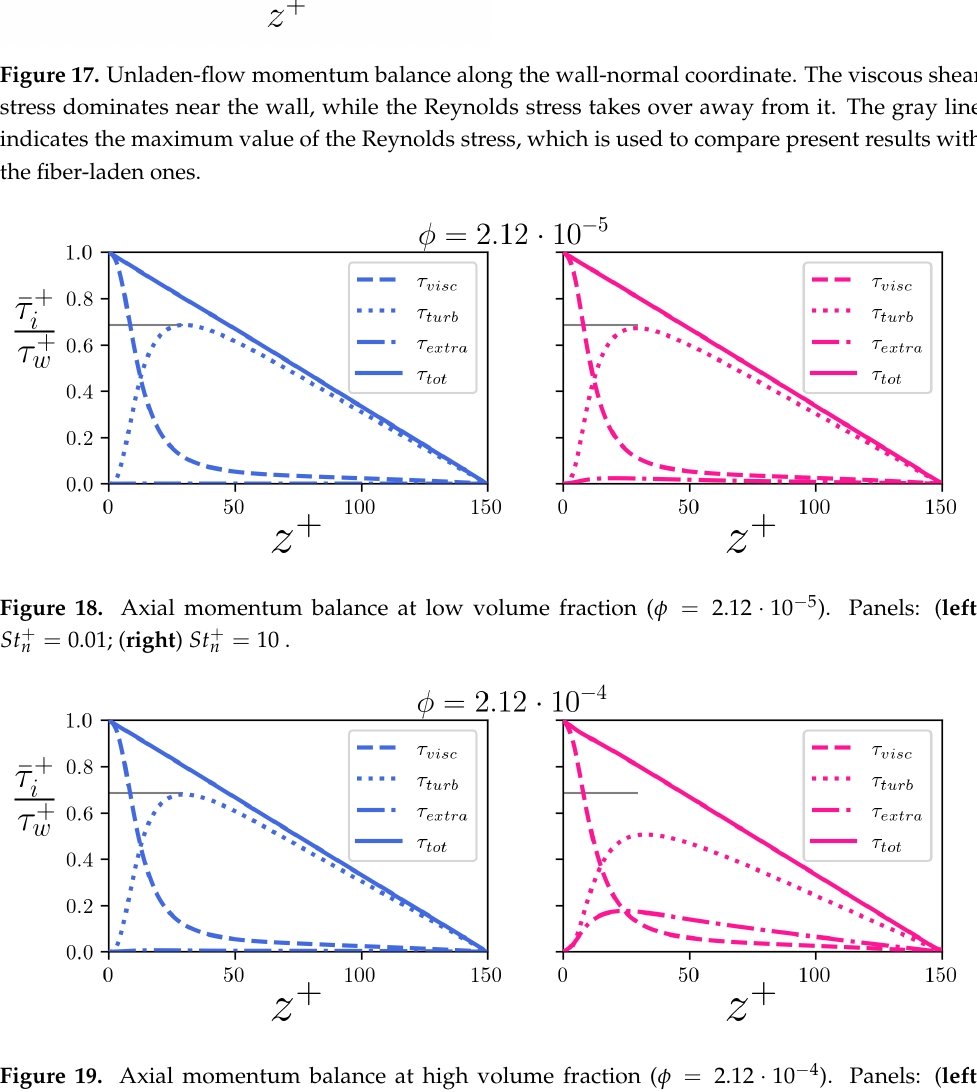
Figure 19. Axial momentum balance at high volume fraction ( φ = 2.12 · 10 − 4 ). Panels: ( left ) St + n = 0.01; ( right ) St + n = 10